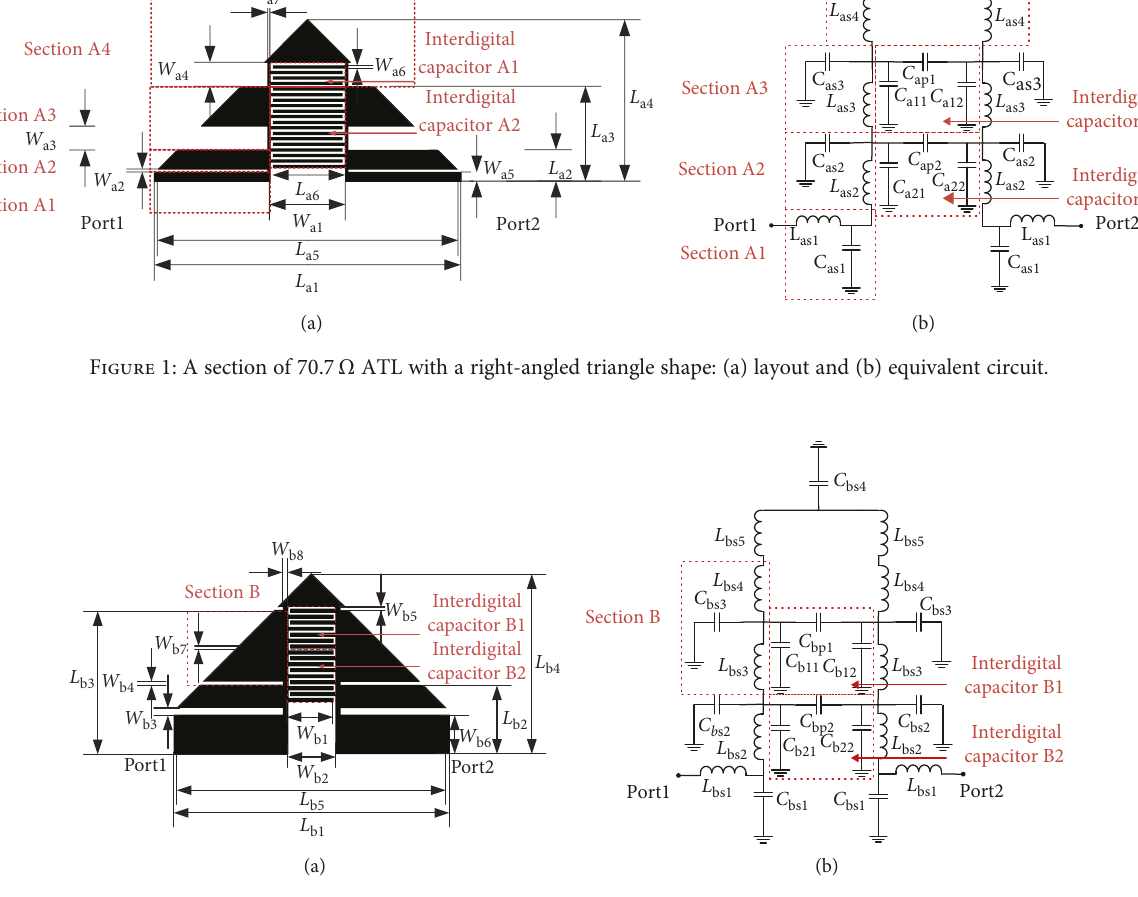
Figure 2: A section of 50 Ω ATL with a right-angled triangle shape: (a) layout and (b) equivalent circuit.